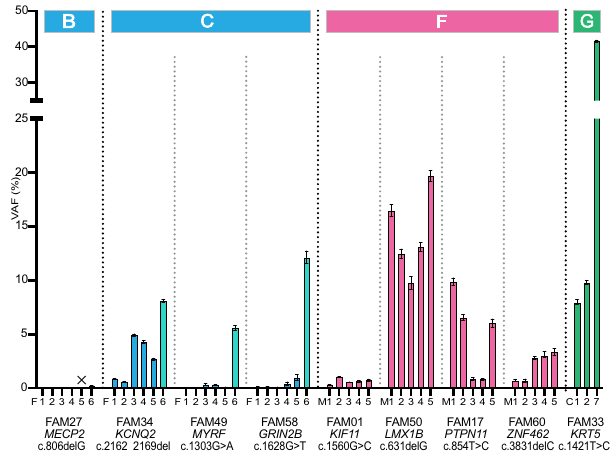
Fig. 3 | Mutation levels observed in the families presenting with mosaicism. Variant allele frequencies (VAF) in different samples from the family member in whom mosaicism was detected by ultra-deep Illumina Sequencing (Deep-NGS). Familynumber,gene,cDNAcoordinatesoftheDNMandtheoriginofthedifferent samplesareindicated onthe x -axisinthesameorderforeachfamily.Thecategory classi fi cation is indicated at the top of the fi gure and the colours re fl ect the par- ental/post-zygotic origin of the DNM (blue [somatic paternal tissues], turquoise [paternal sperm], pink [somatic maternal tissues] or green [post-zygotic/proband tissues]). The ╳ represents a sample failure. Full data for the other family members and controls are presented in Supplementary Fig. S2 and Supplementary Data 2. FAM17 and FAM60 are the two families with multiple affected pregnancies and belongtoCategoryF(maternalmixedmosaicism);notethelowVAFinthematernal blood samples (M3) for both families. Each bar represents a single VAF calculated from the sum of 3 technical replicates, thencorrected using measurements from 3 unrelated controls (corrected VAFs, see “ Methods ” ). Error bars represent the 95% binomialcon fi denceintervals.Abbreviations:Ffather;Mmother;Cchild;1=buccal mucosa (left); 2=buccal mucosa (right); 3=blood; 4=saliva; 5=urine; 6=sperm; 7=genomic DNA from original